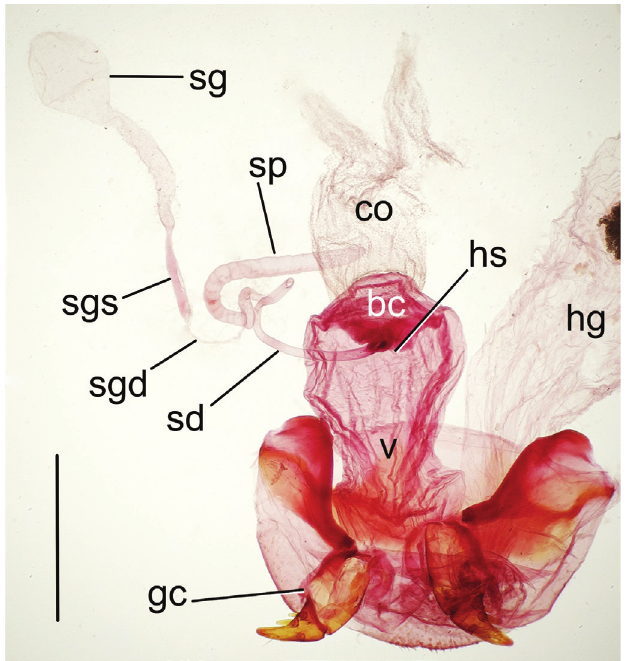
Figure 11. Female reproductive tract of Theprisa darlingtoni , ventral view; scale bar = 0.50 mm. Abbre- viations: bc, bursa copulatrix; co, common oviduct; gc, gonocoxa; hg, hindgut; hs, helminthoid sclerite; sd, spermathecal duct; sg, spermathecal gland; sgd, spermathecal gland duct; sgs, spermathecal gland stem; sp, spermatheca; v,